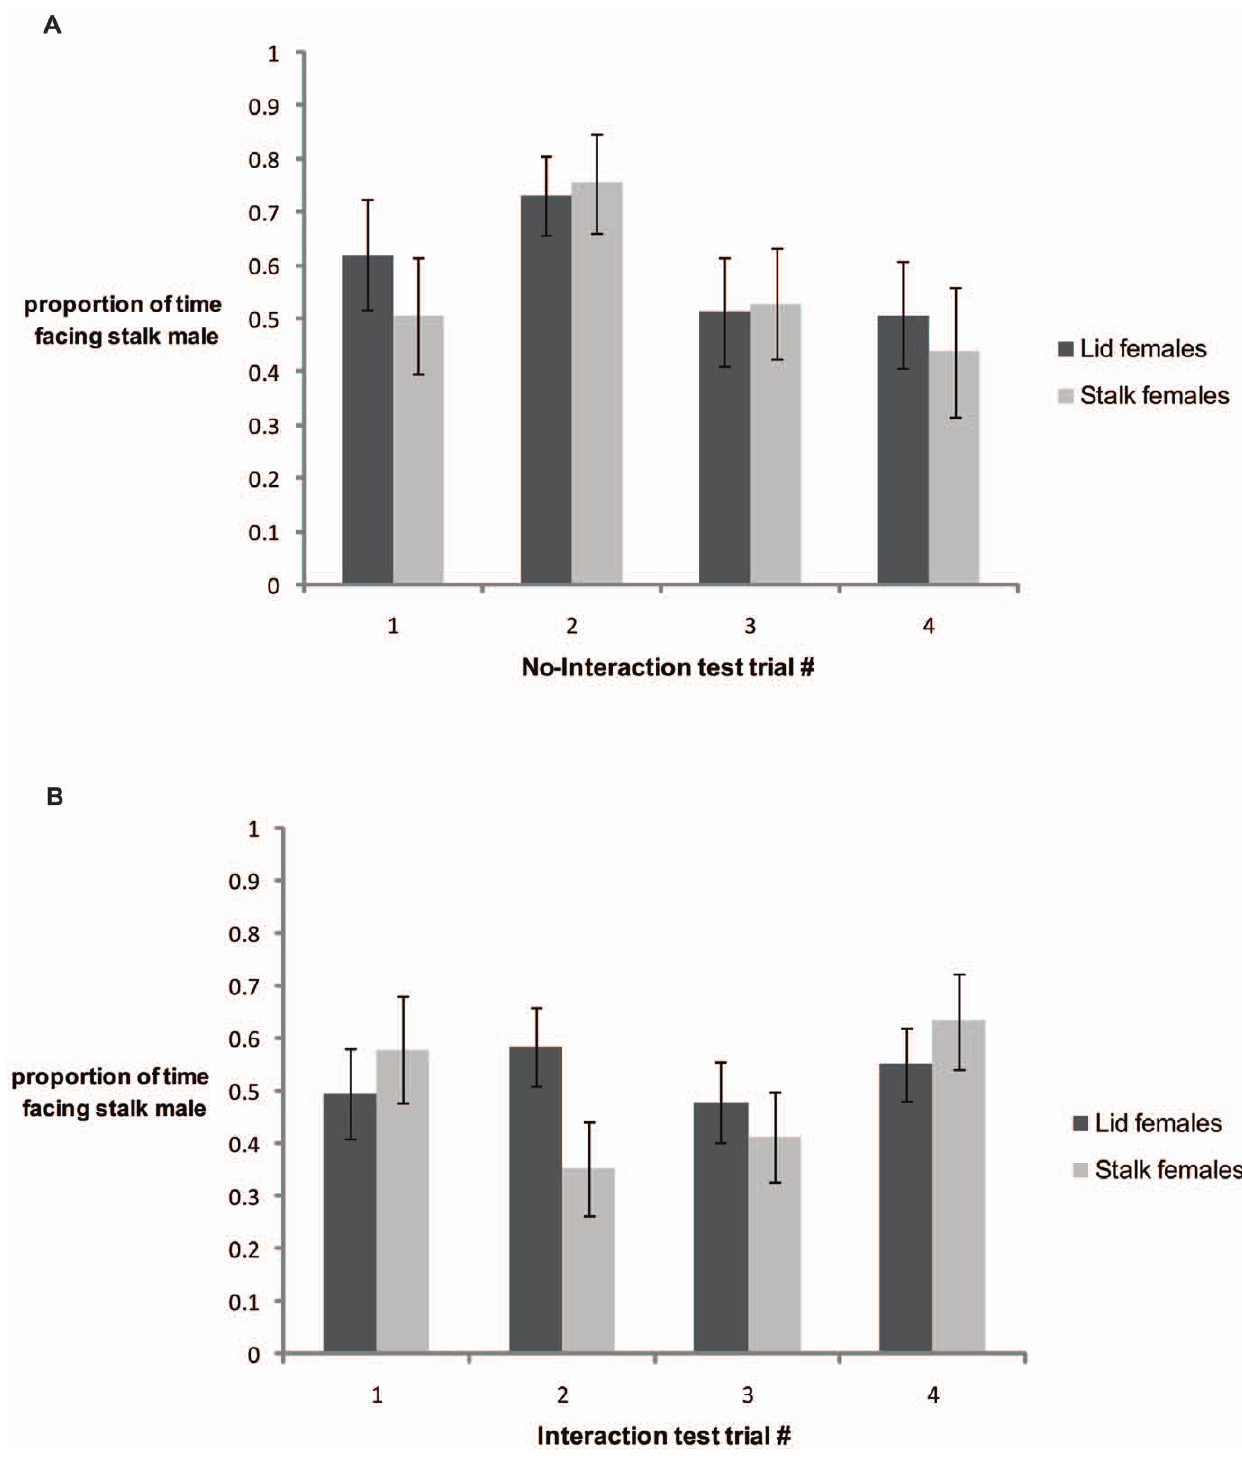
Figure 4. Mean proportion of time ( ± SE) that females trained on the lid task ( N =16, dark grey bars) and females trained on the stalk task ( N =15, light grey bars) spent facing the stalk male’s compartment in each of the four (A) No-Interaction and (B) Interaction test trials. Chance proportion, indicating random choice, is 0.5. doi:10.1371/journal.pone.0014340.g004 subject (Interaction tests). Lid males did not differ significantly Lid males were consistent in their lid task performance (Table 4), both when they were facing their cage companions (No- from stalk males in their task performance in the four No- Interaction tests), and when they were facing the female test Interaction test trials (Bonferroni-corrected a level of significance